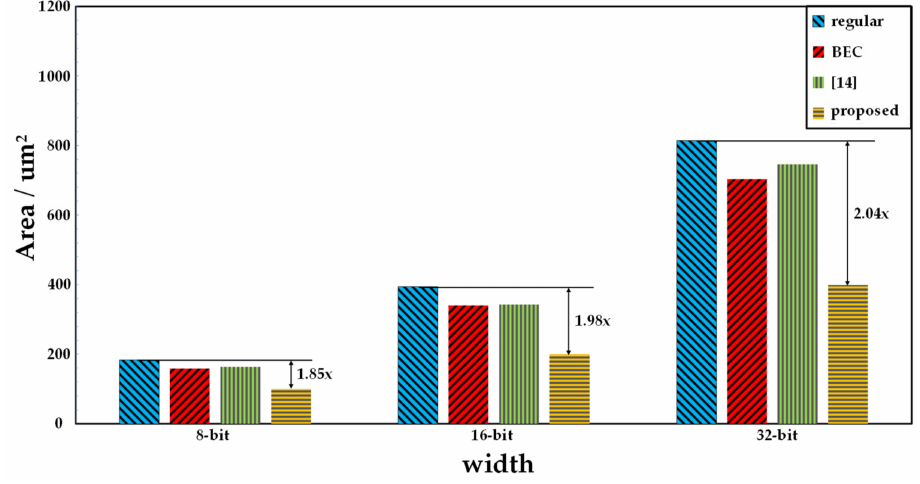
Figure 6. Area comparison among the four types of